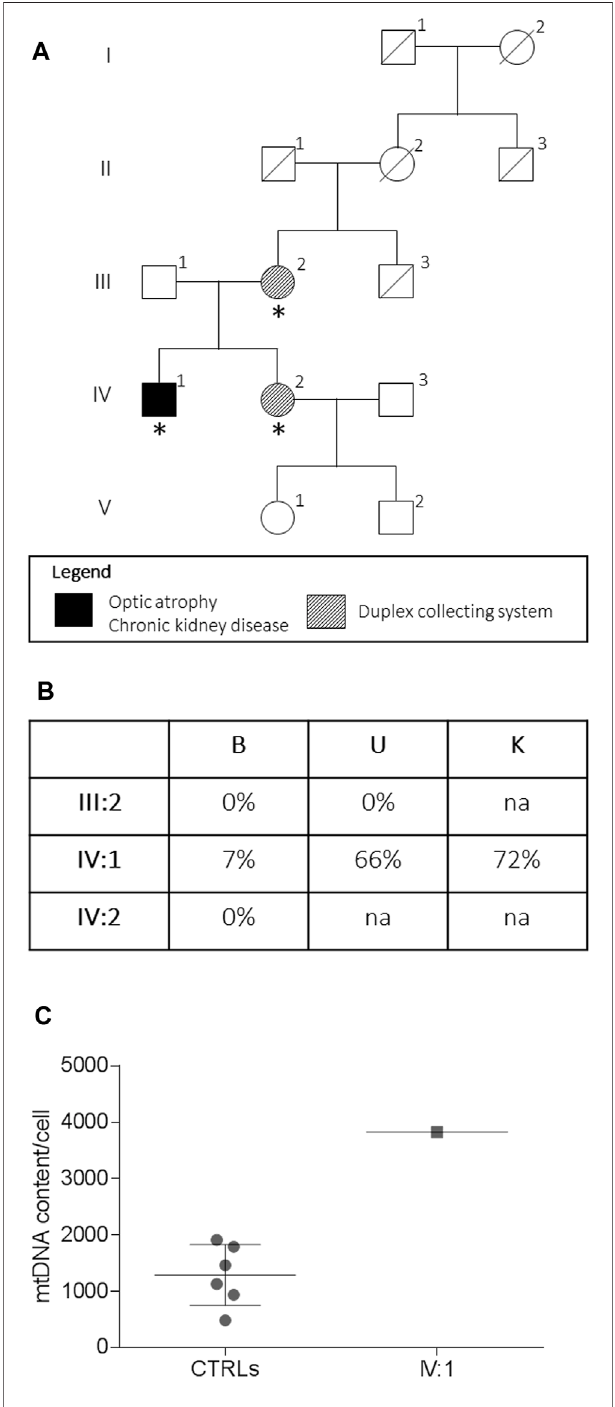
FIGURE 1 | Pedigree and genetic analysis. Pedigree of the family (A) . Asterisks indicate the individual investigated. The m.13513G > A/MT-ND5 variant heteroplasmy (B) in the peripheral blood (B) , urinary sediment (U), and kidney biopsy (K) is reported. The mtDNA content from the kidney (C) from the proband (IV:1, n = 1) and controls (CTRLs, n = 6). Data were presented as a scatter plot with mean and